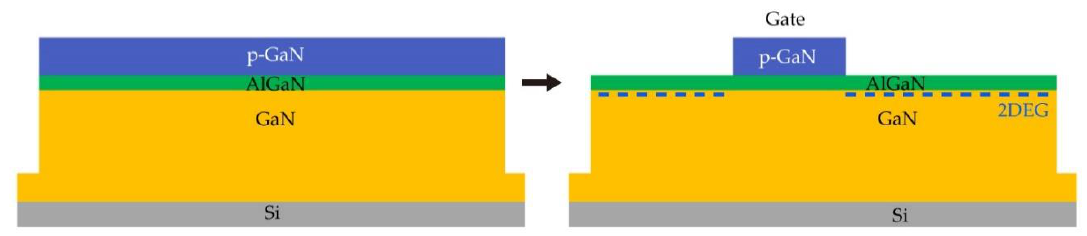
Figure 5. Gate area definition of a p-GaN HEMT.